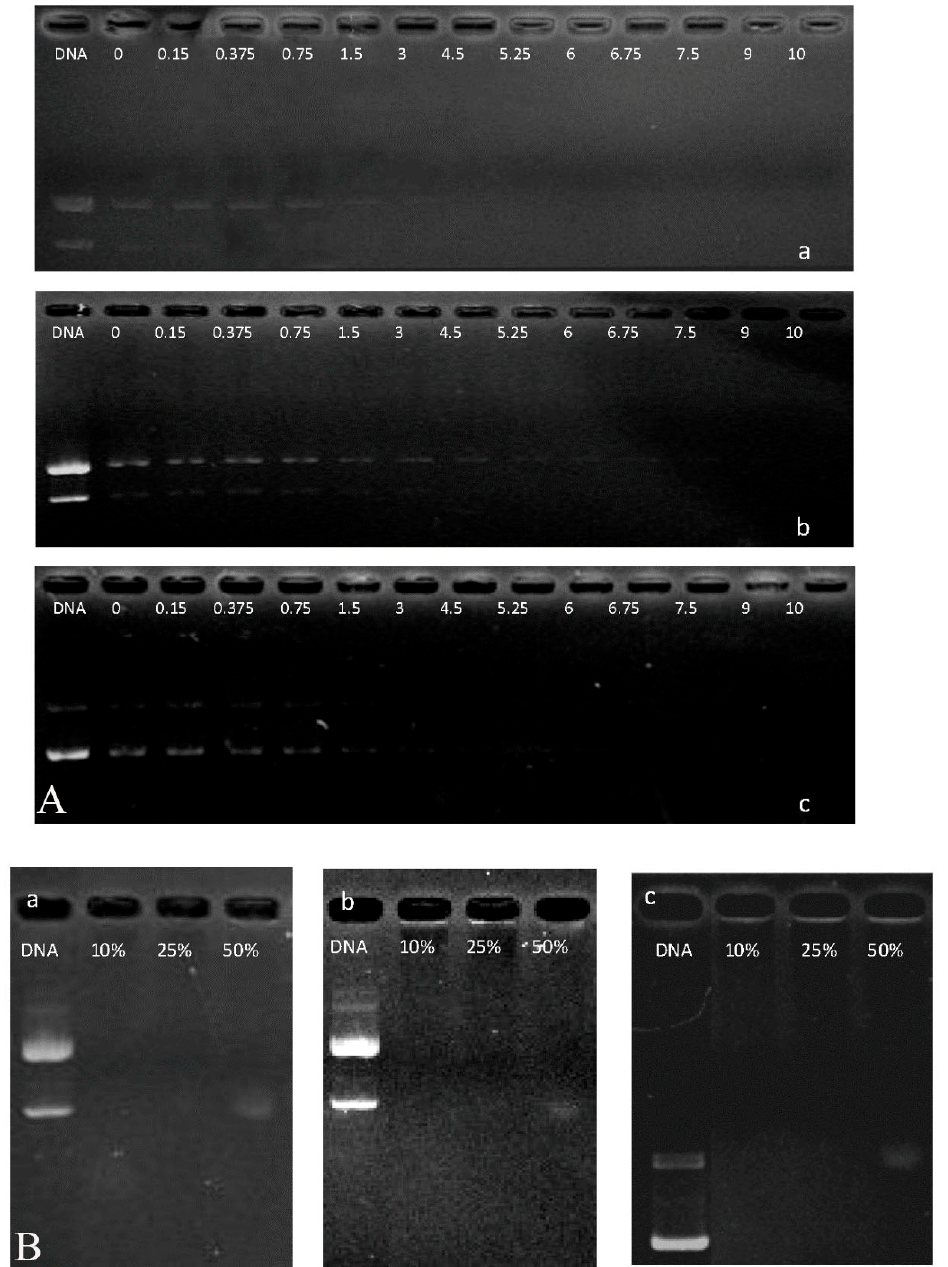
Figure 5. ( A ) Plasmid DNA protection by P123-PEI-R4 ( a ), P123-PEI-R11 ( b ) and P123-PEI-R18 ( c ) from degradation by DNaseI at varying concentrations; ( B ) Plasmid DNA protection by P123-PEI-R4 ( a ), P123-PEI-R11 ( b ) and P123-PEI-R18 ( c ) from degradation by serum at varying concentrations.